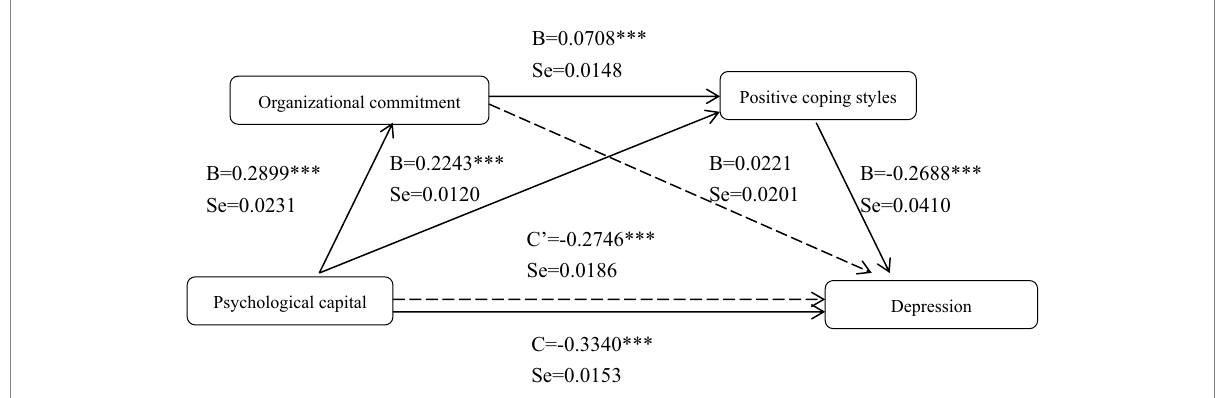
FIGURE 1 The mediating path of depression. B represents the direct effect coefficient of the antecedent variable on the outcome variable conditional on gender and age as covariates, c’ represents the direct effect coefficient of psychological capital on depression conditional on gender and age as covariates and organizational commitment and positive coping style being included in the mediating model, and c represents the full effect coefficient of psychological capital on depression.